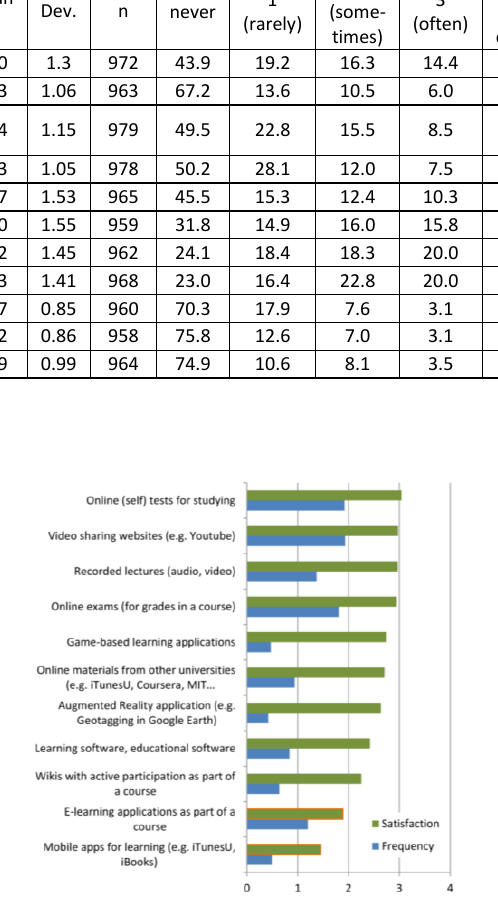
Table 7. Students’ answers to the question: How often do you use the following for lear ning/studying? How often do you use the following for learning/studying?